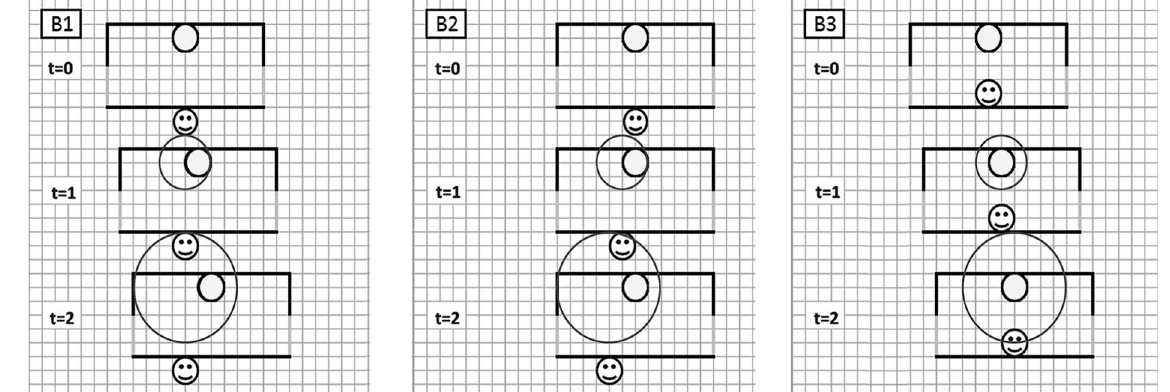
FIG. 3. Task B. EDs to probe the reference frame in which participants think light propagation is uniform. The gray circle represents the correct answers according to SRT. These were not included in the version given to the